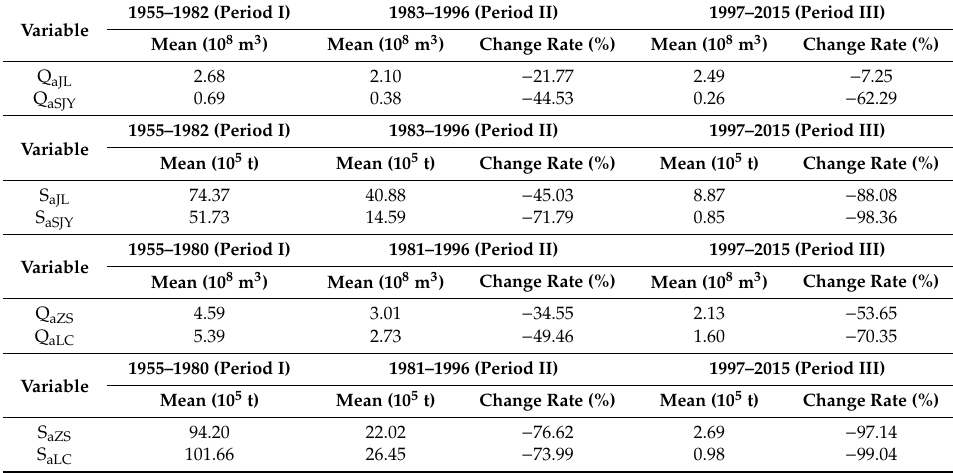
Table 3. Changes in average Q a and S a values during di ff erent periods.